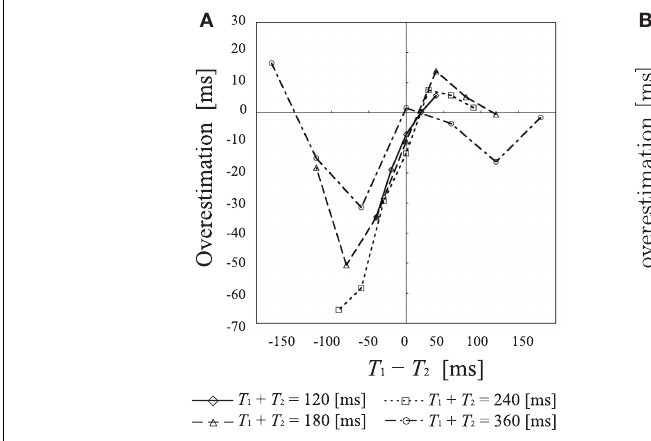
FIGURE 1 | Perceptual and simulated overestimation of T 2 as a function of T 1 − T 2 . Each marker represents a different total duration T 1 + T 2 . (A) Perceptual overestimation of T 2 . Perceptual overestimation is measured by using the method of adjustment. (From Figure 3B, Miyauchi and Nakajima, 2005, with changes in notations. ©University of California